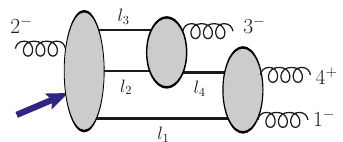
Figure 15. The unitarity cut to determine ∆ (2) , N =4